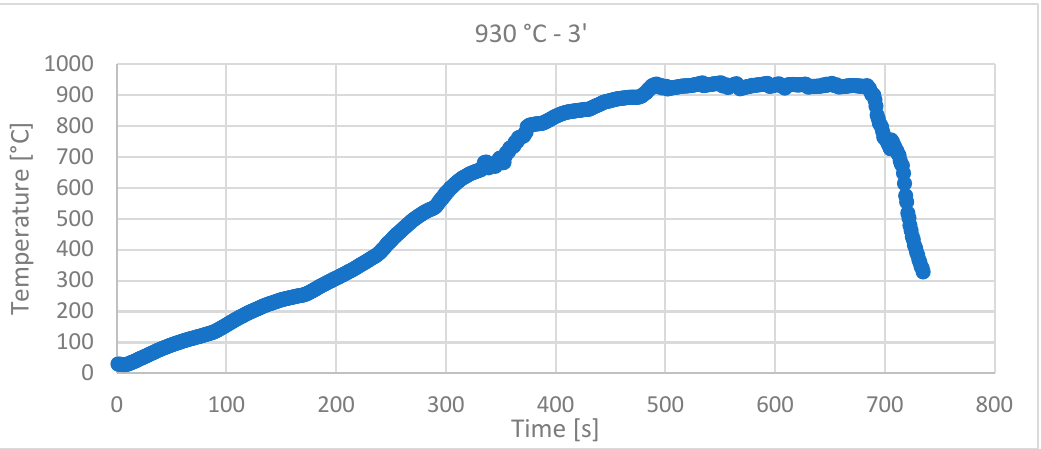
Figure 4. Solar sintering diagram at 930 °C, with 3 min holding time and with a 113.87 °C/min heating rate.